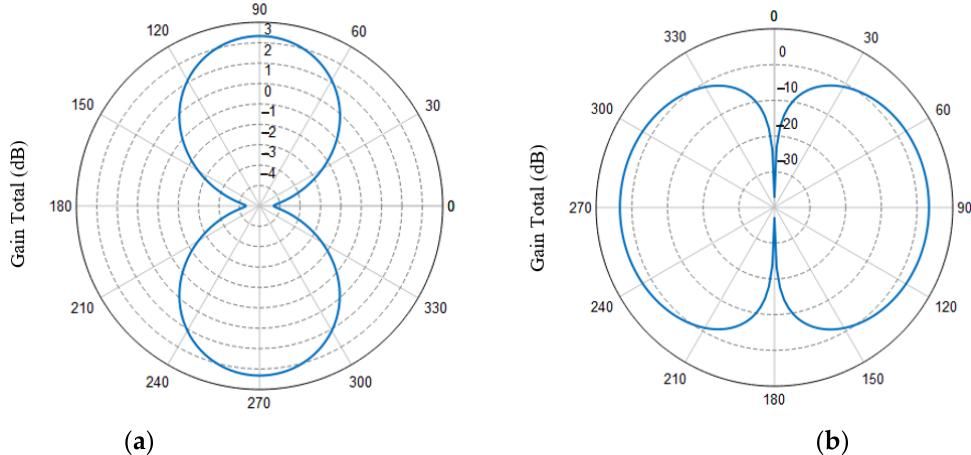
Figure 6. Simulated radiation patterns for ( a ) E -plane; ( b ) H -plane.